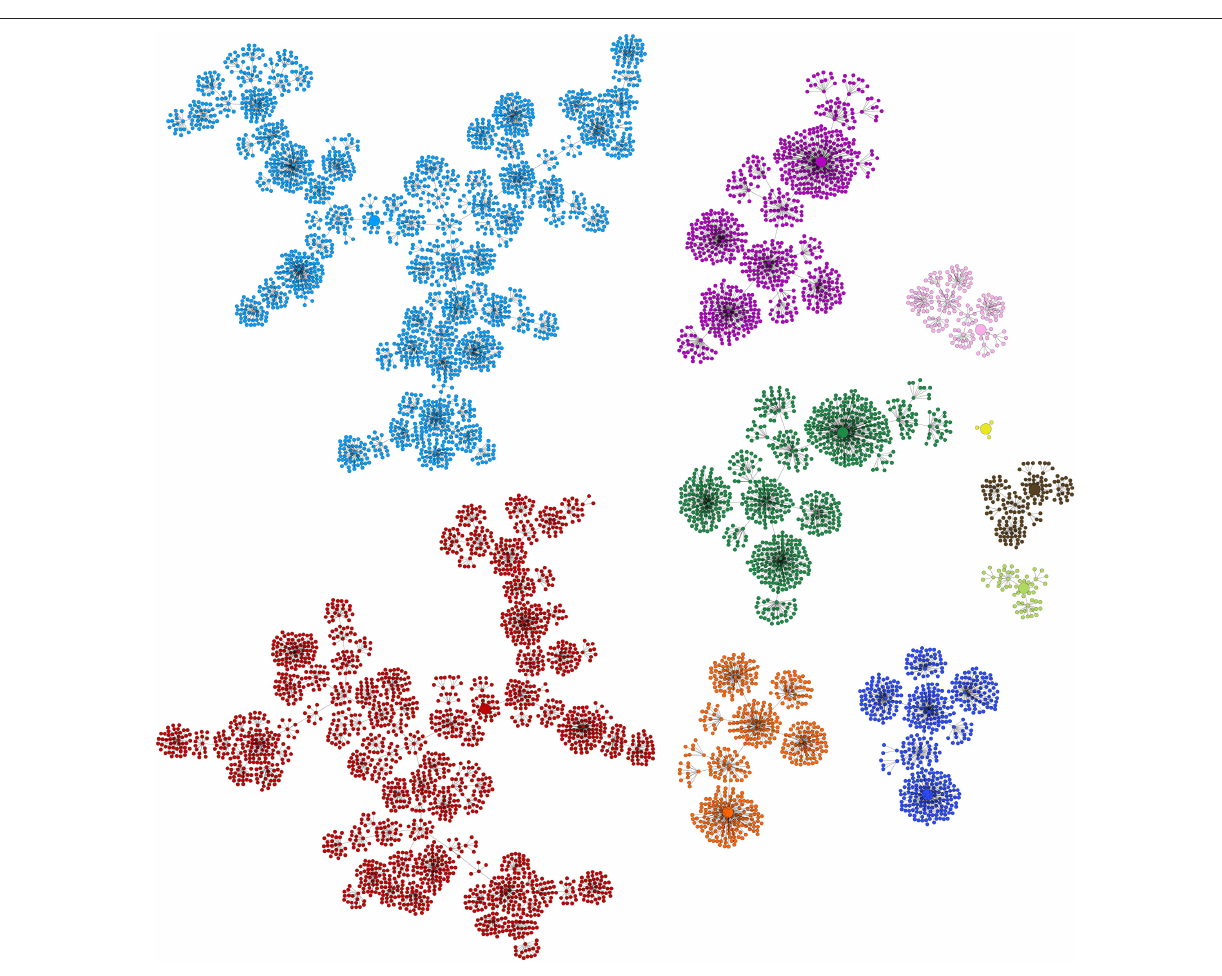
TABLE 3 | Frequency of sizes of basins of attraction for the 10 known fixed-point attractors of Figure 4 in a sample of 328,565 Boolean networks found by Griffin that recover the exact set of fixed-point attractors. I1